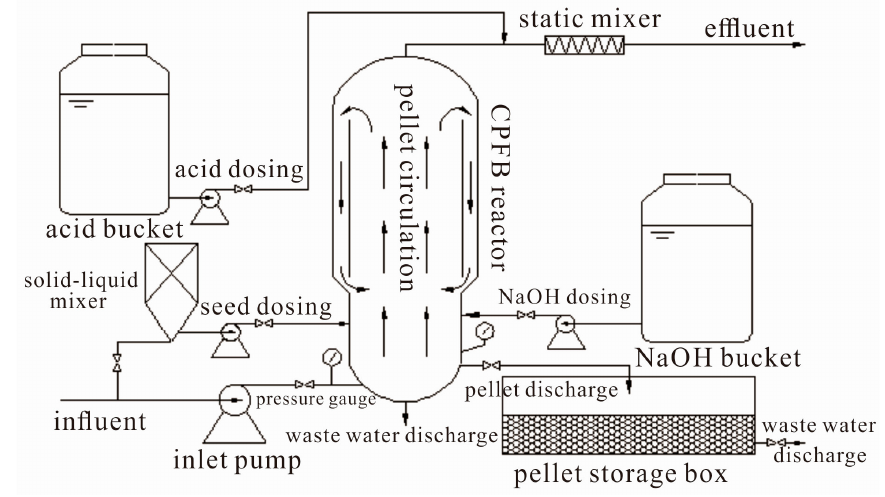
Figure 1. Schematic diagram of the full-scale pellet softening reactor.